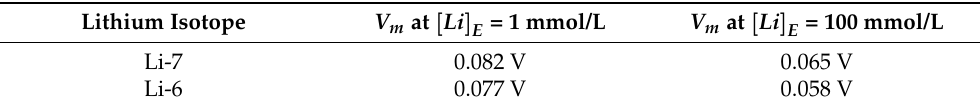
Table 28. The table shows the membrane potential values at extracellular lithium concentration of 1 mmol/L and 100 mmol/L and based on the quantum transport and the corresponding setting values as in graph (b) of Figure 10.